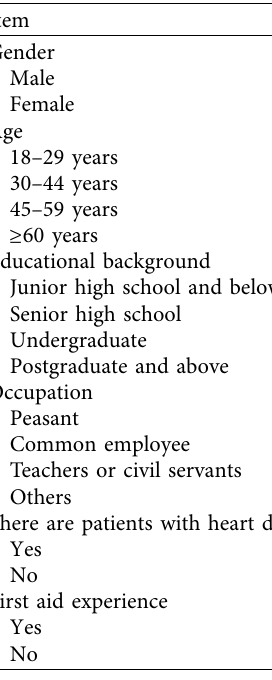
Table 1: Demographics of BLS trainees ( n �